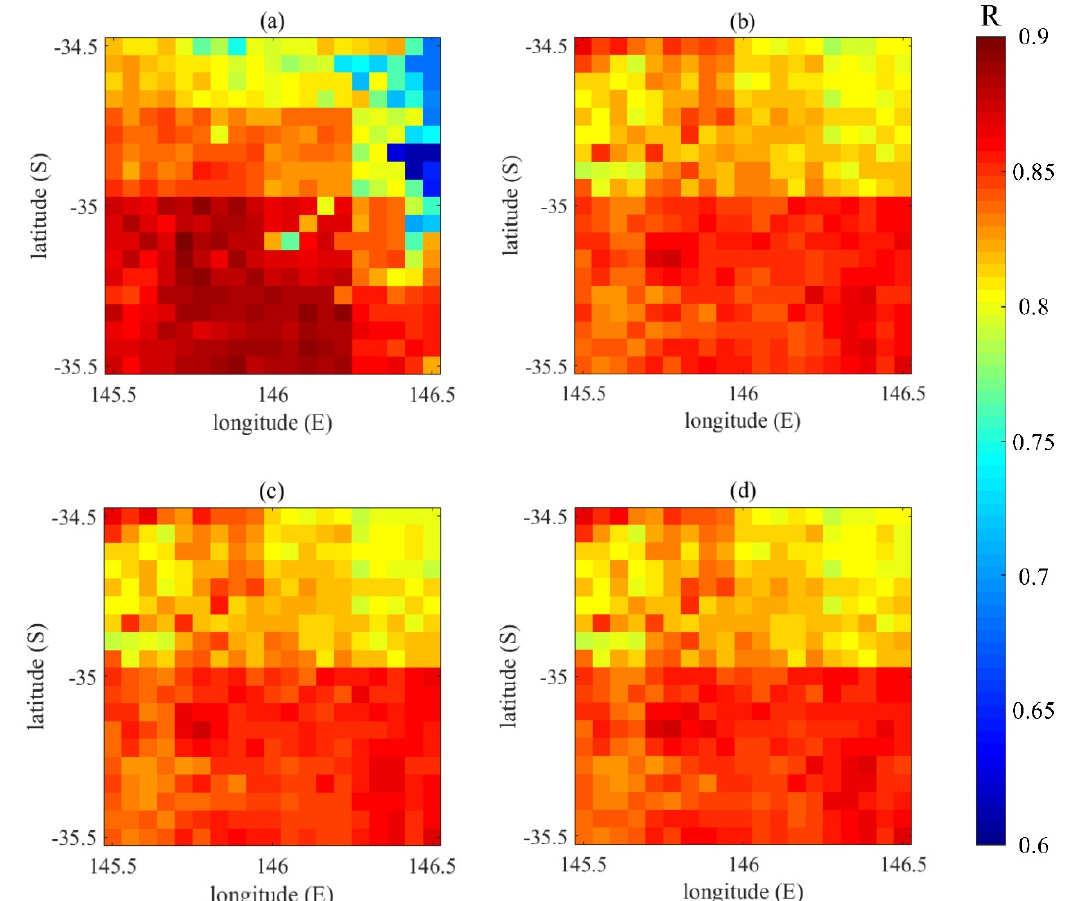
Figure 5. The different correlation coefficient (R) values between the CCI data and: ( a ) VIC simulation; the BGM method using the breeding lengths of ( b ) 24 h; ( c ) 48 h; and ( d ) 72 h.